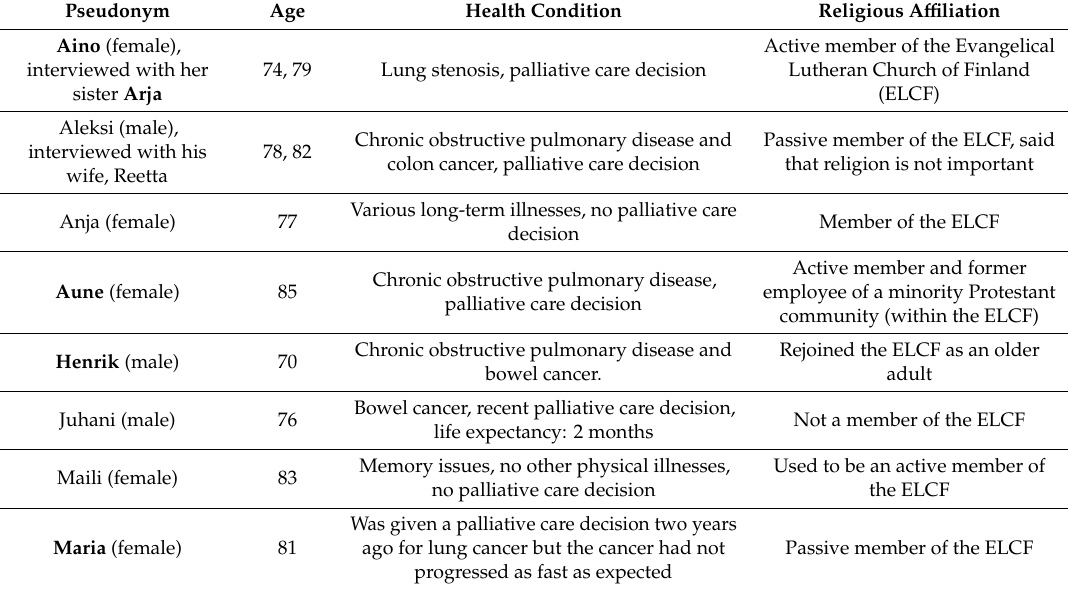
Table 1. Background information of the participants. Bold indicates participants whose interviews are analyzed in this